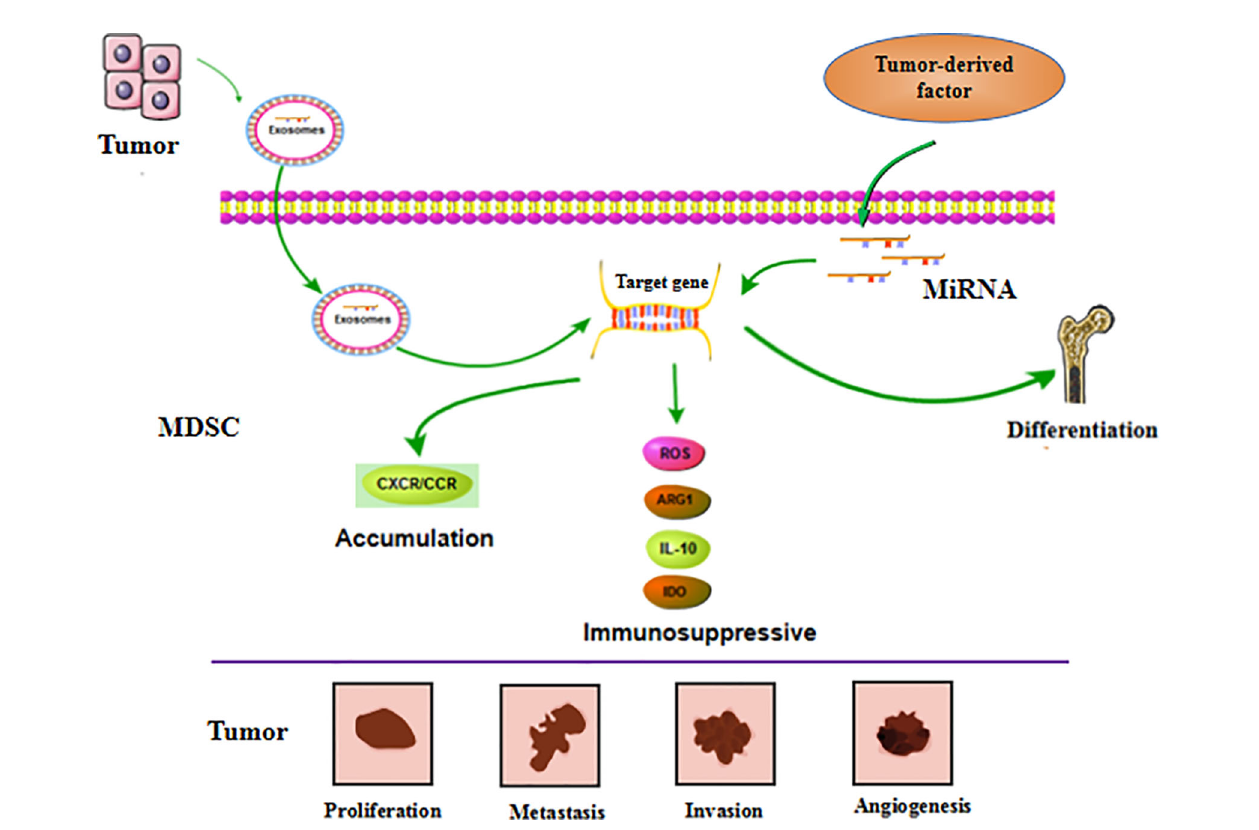
FIGURE 4 | MiRNA affects tumor progression by regulating MDSC. MiRNA is involved in regulating the differentiation, accumulation and function of MDSC. These miRNAs can be derived from MDSC itself. Furthermore, it ’ s also generated by tumor cells and transported to MDSC through exosomes to exert function. These regulatory effects ultimately affect tumor cell proliferation, metastasis, invasion, and vascular